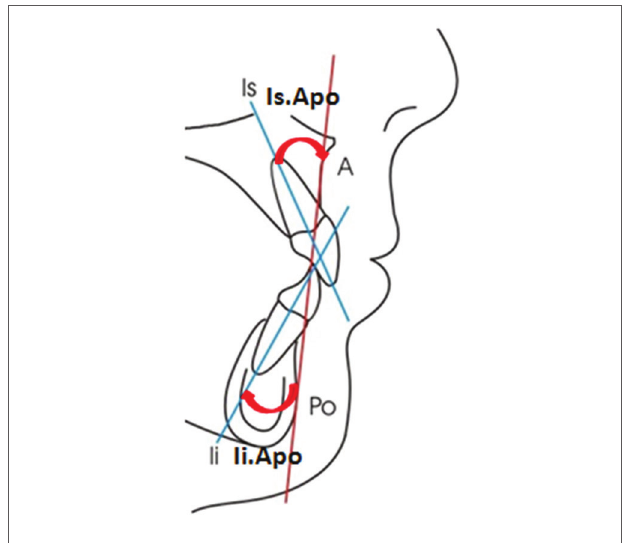
Table 1. Cephalometric mean and standard deviation values. Measures